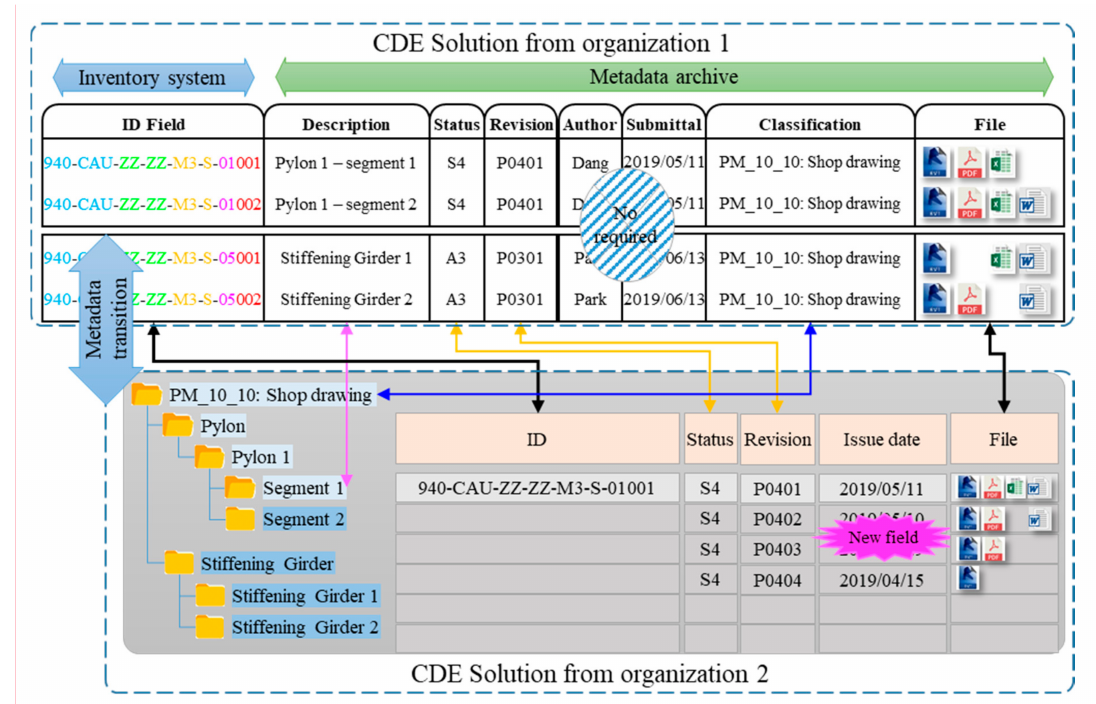
Figure 3. Metadata management through common data environment (CDE)